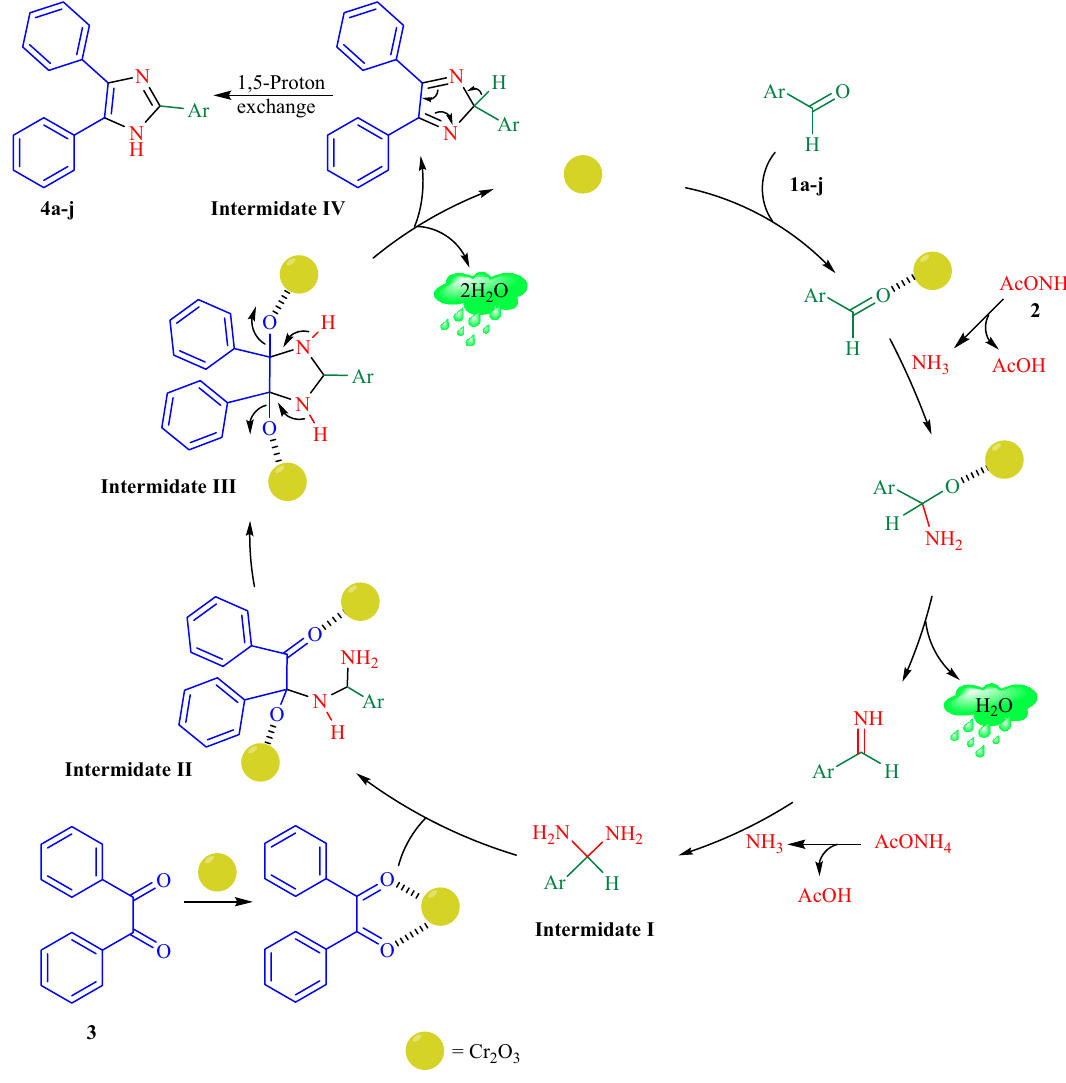
Figure 11. Plausible reaction mechanism for the synthesis of imidazole